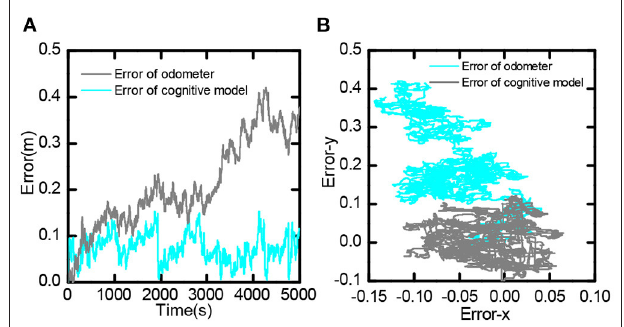
FIGURE 16 | Comparison of bionic cognition and odometer trajectory error, the black curve represents the real trajectory of the robot. (A) The red curve represents the bionic cognitive trajectory. (B) The red curve represents the odometer trajectory. Obviously, the bionic spatial cognitive trajectory is closer to the real trajectory.